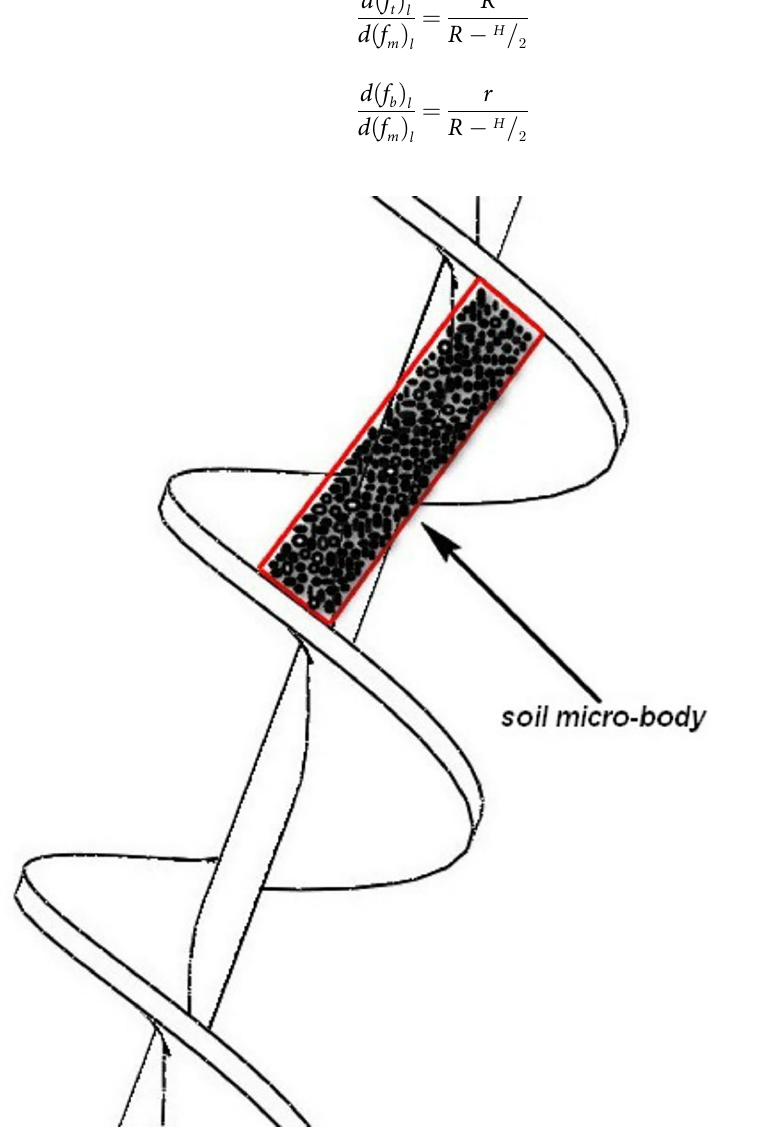
Fig 4. The studied